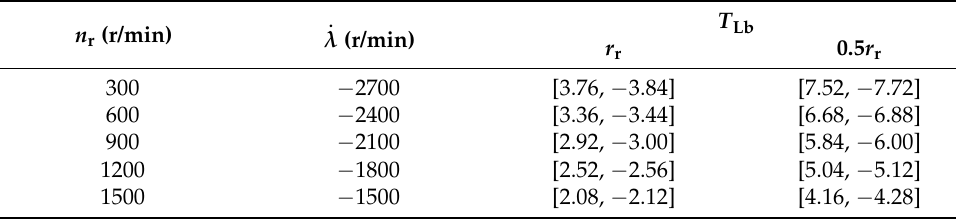
Figure 8. The bounds of the load torque when speed and CM rotor flux vary. Table 3. The boundaries of load torque at ψ (cid:48) cr = 0.7